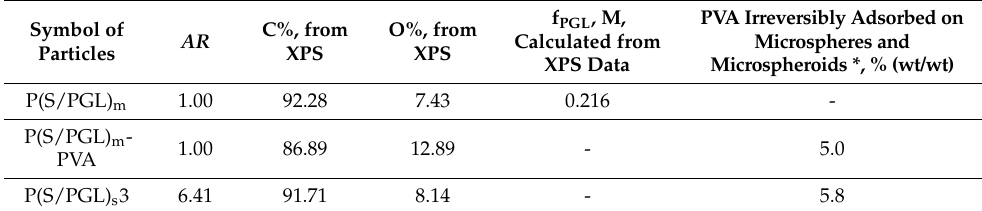
Table 2. Chemical composition of the P(S/PGL) spherical and spheroidal particles and surface fraction of adsorbed